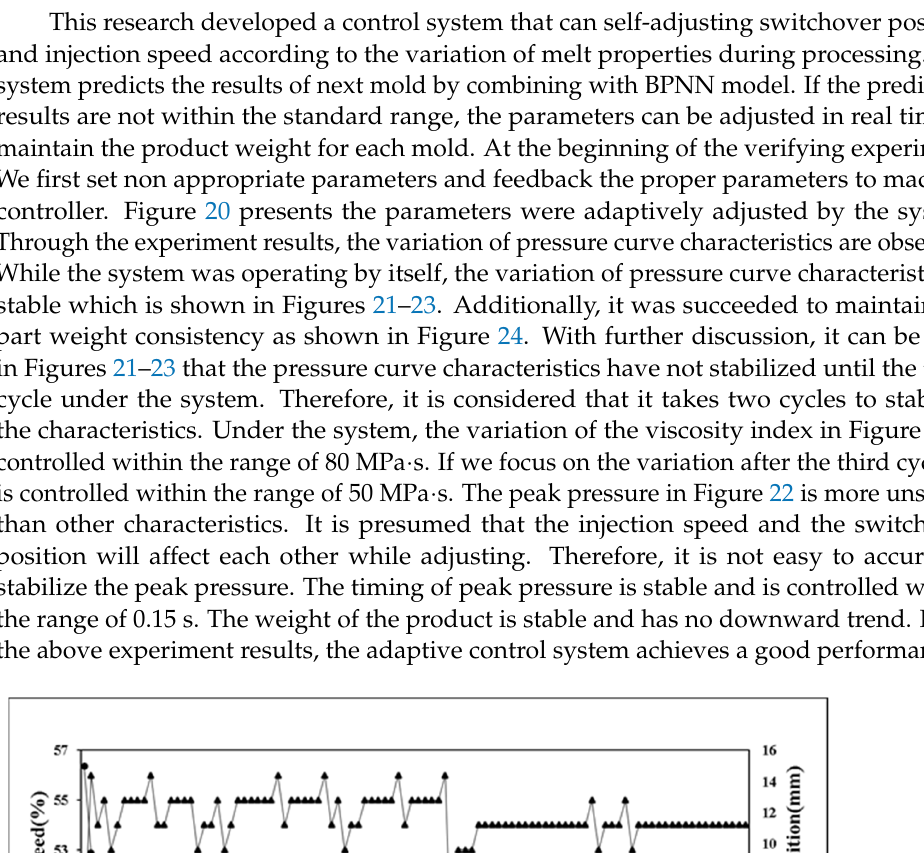
Figure 19. Prediction results of timing of peak pressure. Table 3. Error of prediction results.